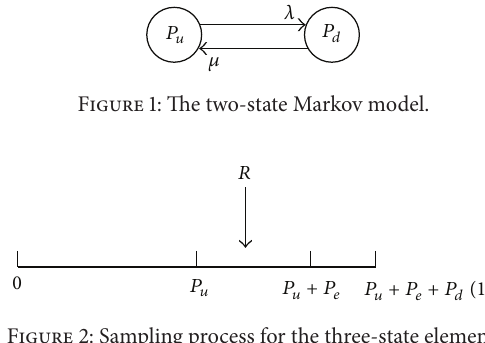
Figure 2: Sampling process for the three-state